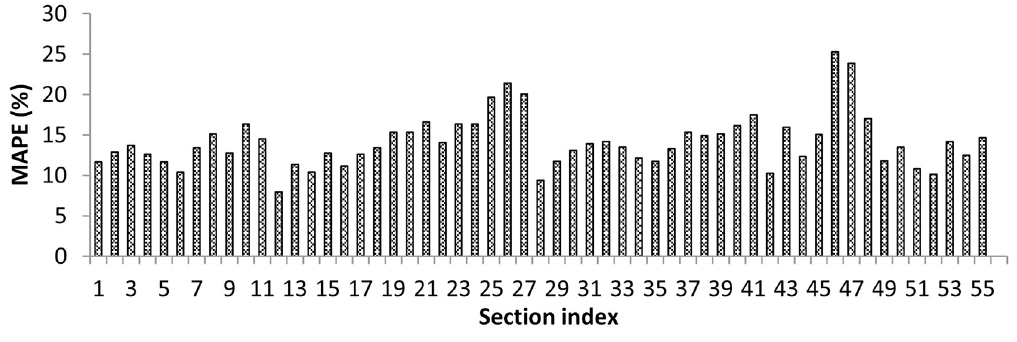
Fig 11. MAPE across sections on a sample